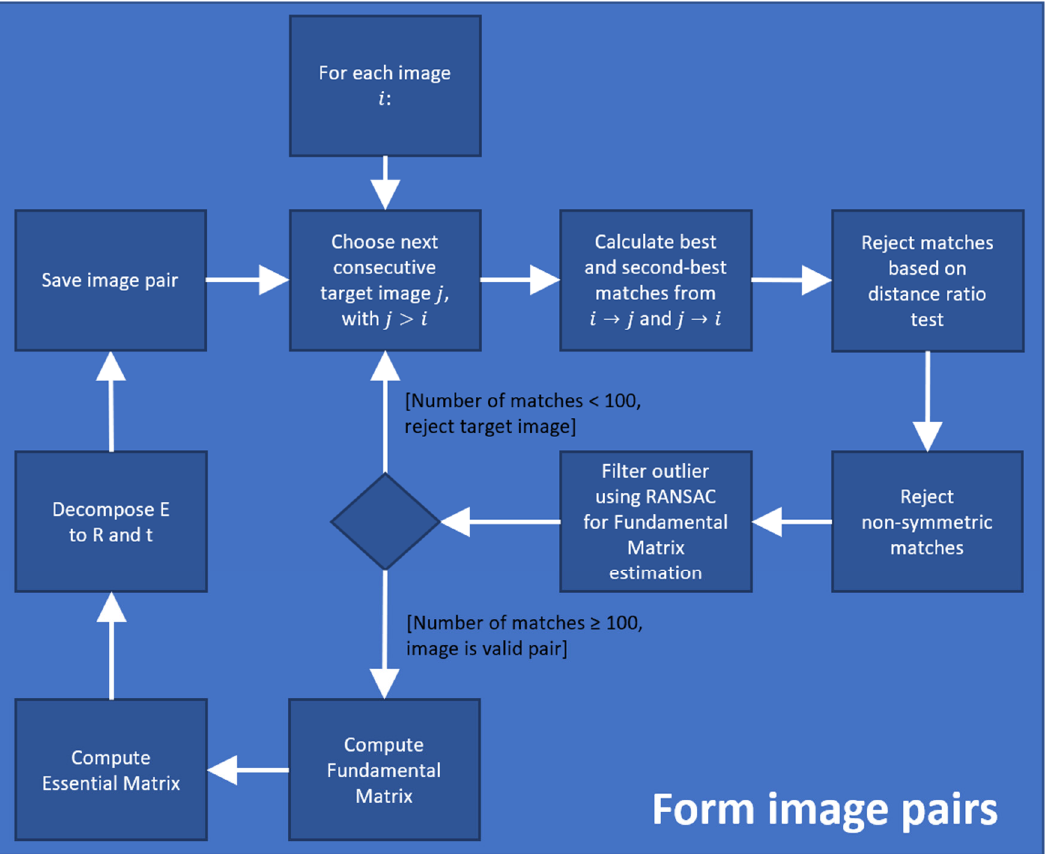
Figure 10. Procedure for image pair formation.